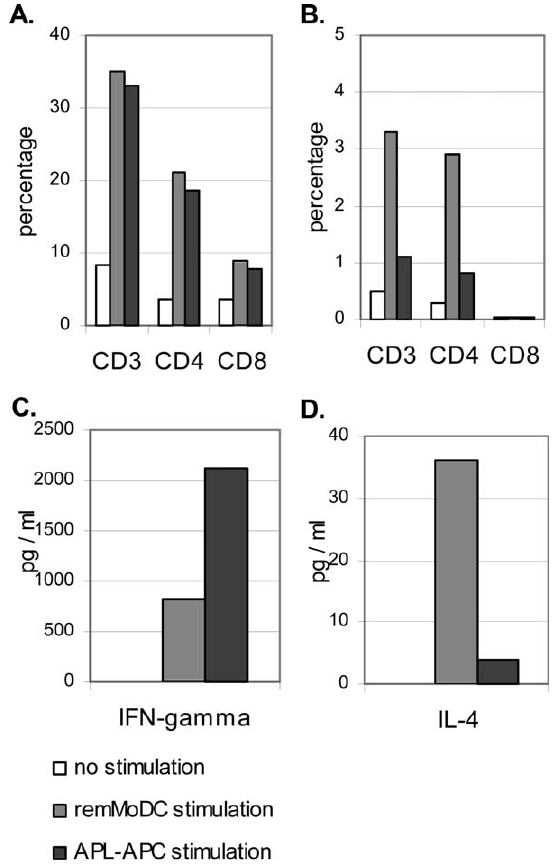
Fig. 2. Cytokine analysis of autologous remission T cells. In panel A, percentages of IFN- γ -producing T cells are shown; in panel B, per- centages IL-4-producing T cells. No IL-4 production could be found in CD8-positive cells. Panel C and D depict cytokine production of remMoDC- and APL-APC-stimulated T cells and unstimulated T cells 24 h after re-stimulation as assessed by ELISA. The number of lymphocytes was equal in all